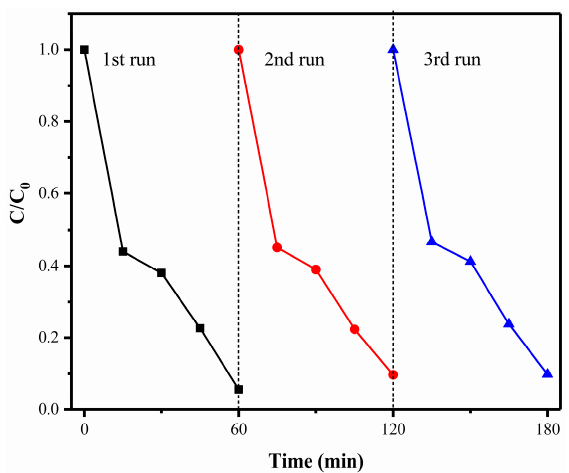
Figure 11. Cycling experiment of the degradation of Rhodamine B (RhB) with 1% S-doped Bi 2 MoO 6 samples.